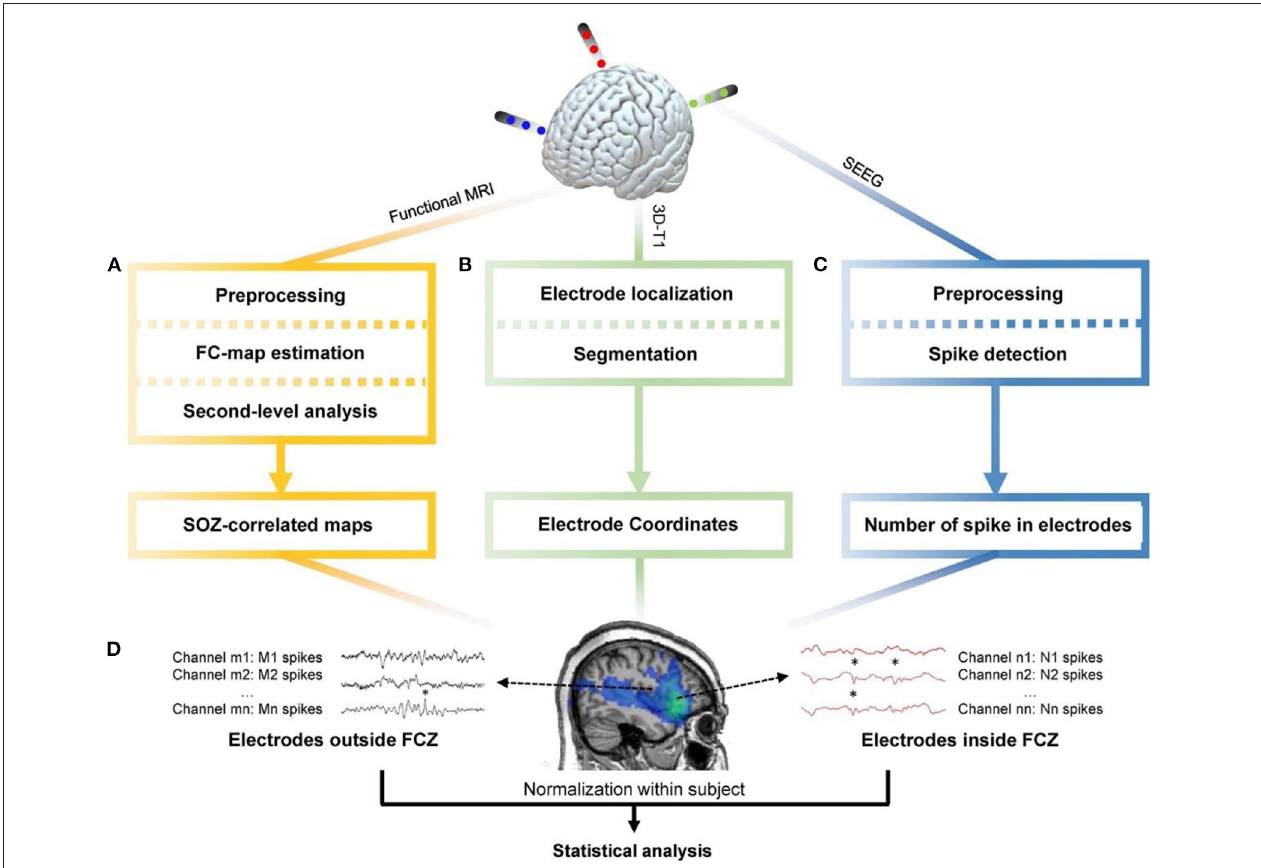
FIGURE 10 | The general pipeline of the research (130). (A) Functional MRI data were preprocessed through realignment, slice timing, outlier detection, coregistration, segmentation, spatial smoothing, and noise regression. Then the maximal BOLD response and its neighboring 26 voxels were used as seed regions to calculate the seed-based functional connectivity maps. One-sample t -test was applied to determine regions with significant functional connectivity. (B) Preimplantation 3D-T1 images were segmented to obtain the brain region. The postimplantation 3D-T1 images were first coregistered to the pre-implantation images, and then the location of electrodes was determined. (C) The iEEG data were resampled to 200Hz, band-pass-filtered between 10 and 60Hz, and notch-filtered at 60Hz to eliminate noise. Spike detection based on signal envelope distribution modeling was applied afterward. (D) The number of IEDs in each channel was normalized by the median number of IEDs in each subject. Statistical analysis was performed to determine group difference of IED rates between channels inside and outside the FCZ